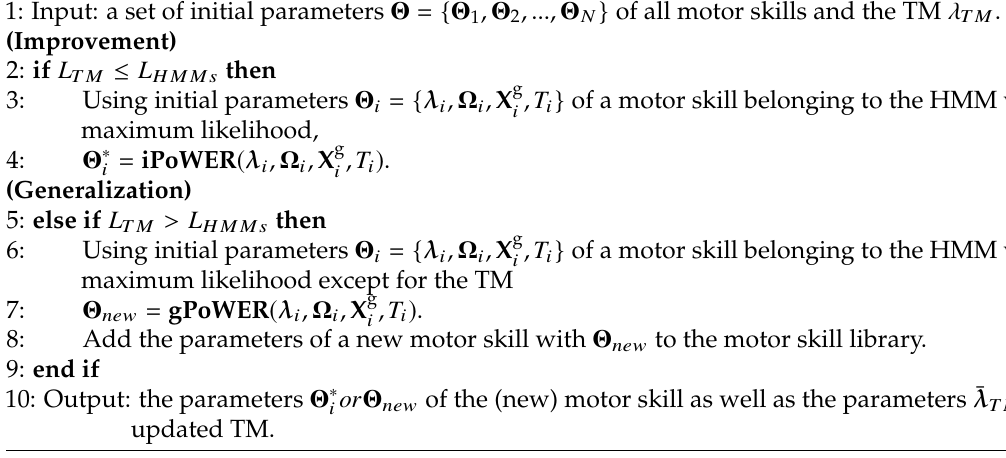
Algorithm 1 Overall algorithm for improving and/or generalizing motor skills